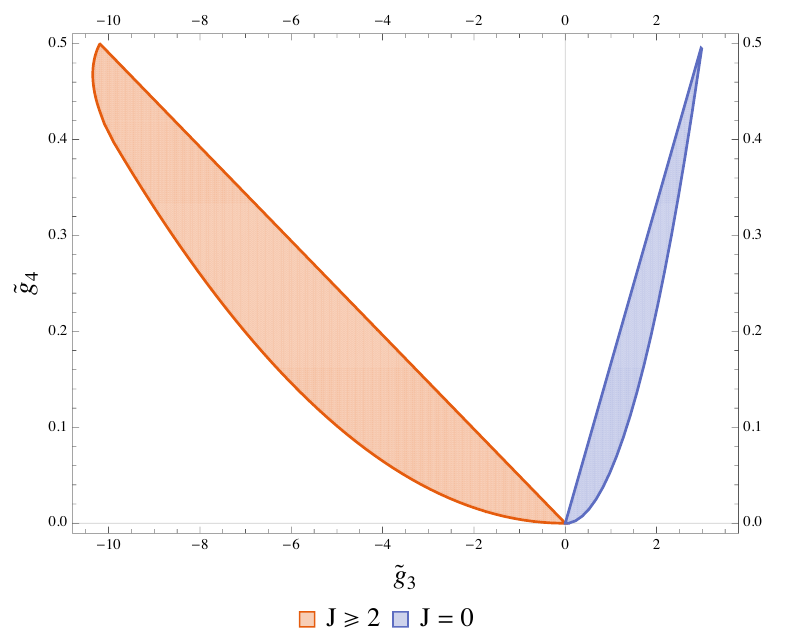
Figure 9. The (˜ g 3 , ˜ g 4 ) allowed region, segmented into theories without spinless particles ( J ≥ 2 ) and theories with only spinless particles ( J = 0) . The convex hull of these two regions reproduces figure